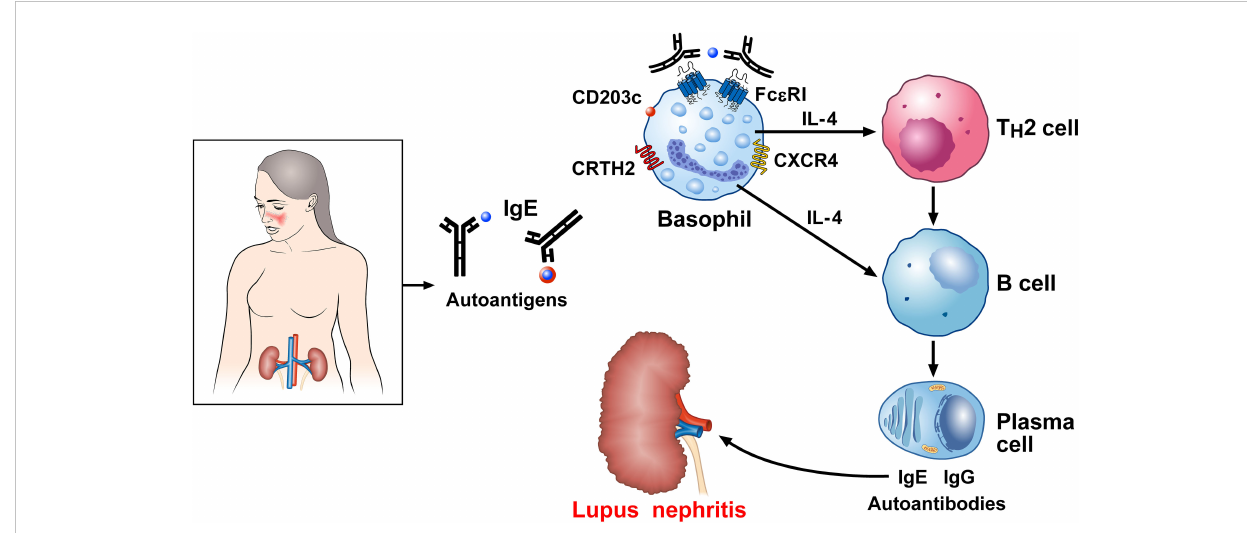
FIGURE 5 Proposed mechanism linking IgE basophils to autoimmunity in systemic lupus erythematosus (SLE). Serum IgE levels are increased in SLE and correlate with severe disease manifestations (76, 173 – 175). IgE against several autoantigens have been reported in SLE (171, 173, 177 – 182). Basophils from SLE patients show an activated phenotype in overexpressing CD203c (76), the prostaglandin D 2 (PGD 2 ) receptor [chemoattractant receptor- homologous molecule (CRTH2) expressed on Th2 cells], and CXCR4, the receptor for CXCL12 (185). Once recruited to the secondary lymphoid organs, activated basophils release IL-4, which drives B cell isotype switching toward IgE and autoreactive IgE (177, 181). Dendritic cells (DCs) in lymph nodes also act on B cells, triggering their differentiation into plasma cells and potentiating the formation of self-reactive autoantibodies (186). IgE immune complexes contribute to basophil activation. Deposits of IgG and IgE autoantibodies in the kidney play a major role in lupus